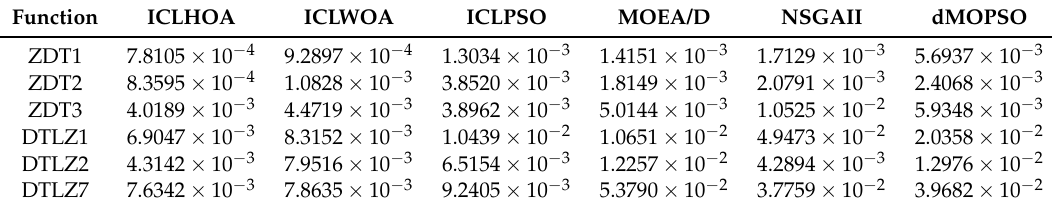
Table 1. Inverse generation distance (IGD) value of each optimization algorithm.